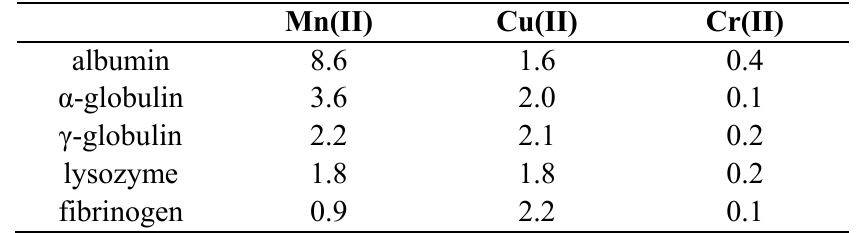
Table 3. The proton relaxation rate enhancements ( ε * ) calculated from Equation